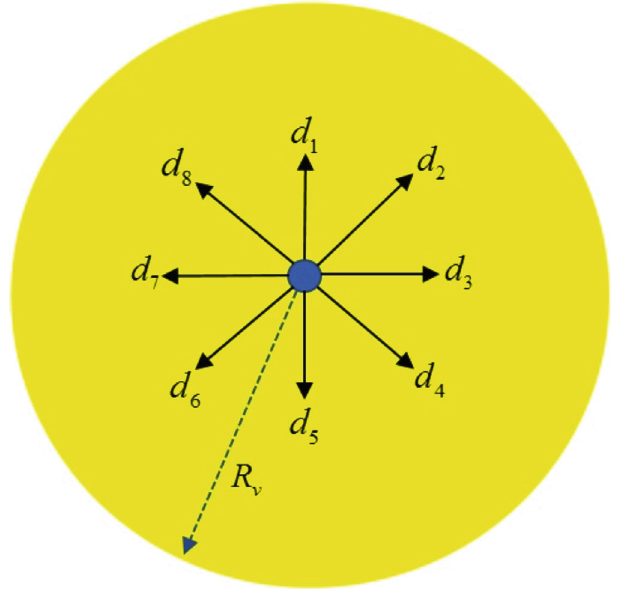
Figure 1: Visibility domain and movement directions [11].